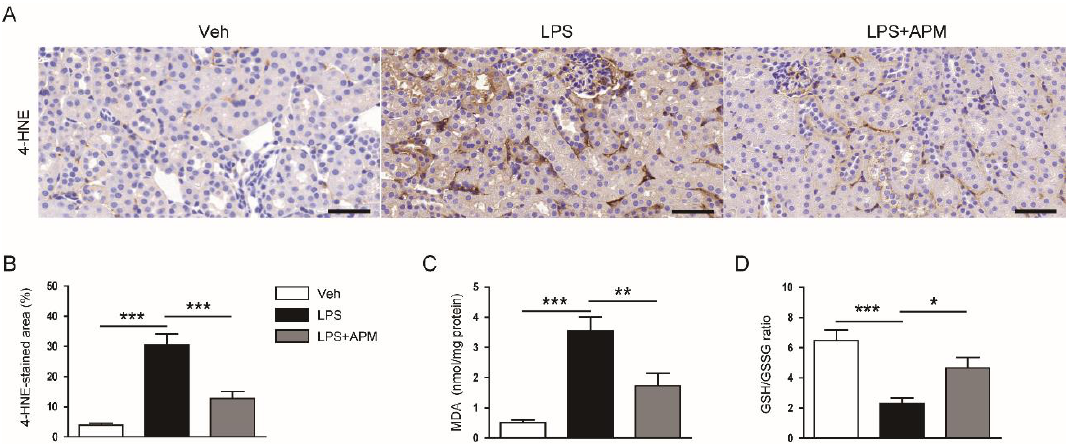
Figure 5. Effect of apamin on LPS-induced renal oxidative stress. ( A ) Immunohistochemical staining of kidney tissues for 4-hydroxynonenal (4-HNE). Scale bars: 50 μm. ( B ) Percentage of stained areas for 4-HNE. ( C ) Renal malondialdehyde (MDA) levels. ( D ) reduced glutathione (GSH)/oxidized glutathione (GSSG) ratio. n = 8 per each group. * p < 0.05, ** p < 0.01, and *** p < 0.001.